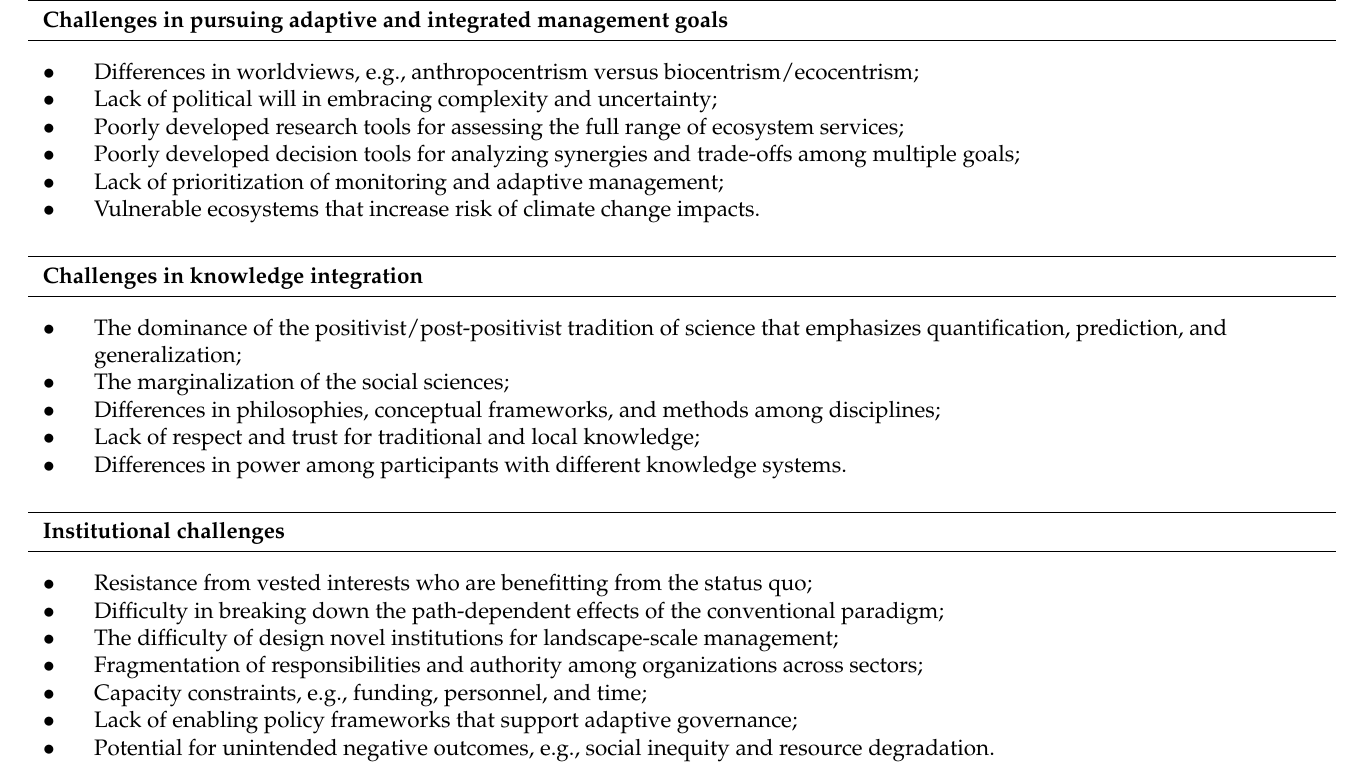
Table A2. Challenges for ecosystem-based climate-smart